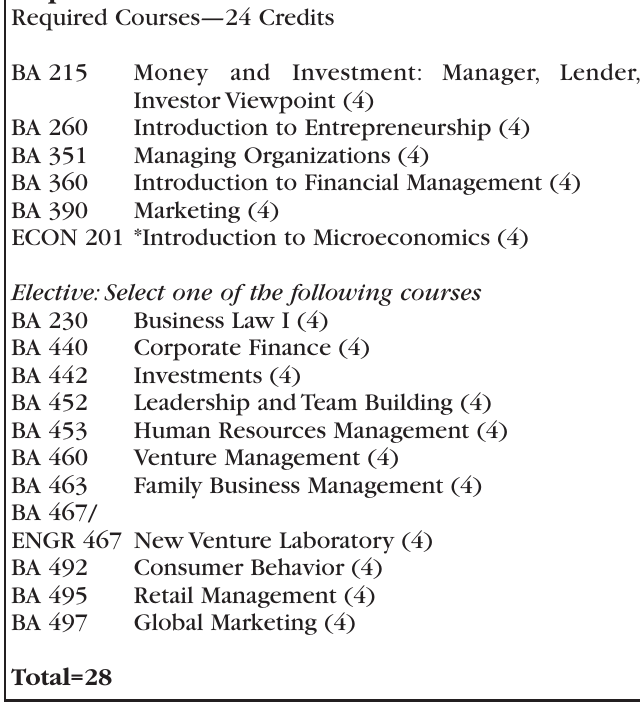
Figure 2. Entrepreneurship